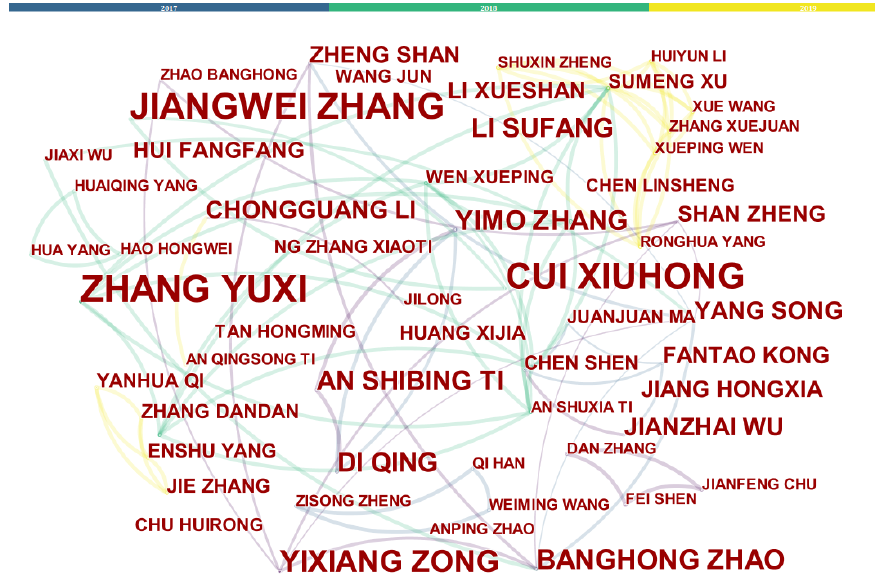
Figure 3. CNKI Cooperation Network Analysis Diagram.